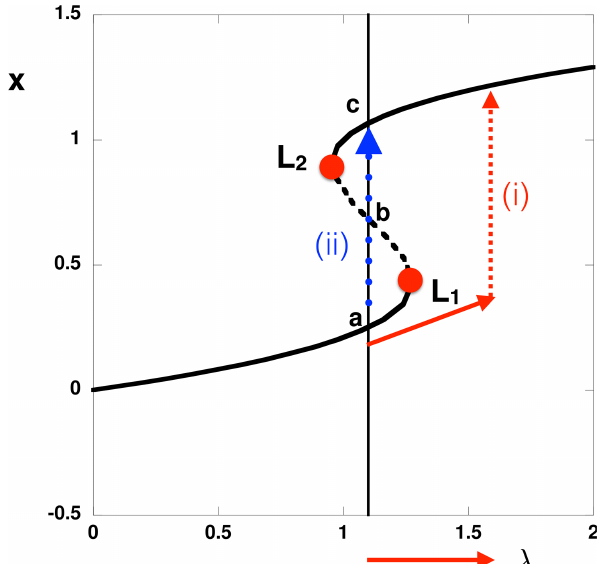
Figure 4. The canonical bifurcation diagram with the back-to-back saddle node indicating two stable states (a, c) and an unstable state (b). Bifurcation tipping occurs when the parameter λ crosses the value at L 1 or L 2 . Noise-induced tipping (e.g., from state a to state c) can occur through a perturbation in the state vector (for fixed λ